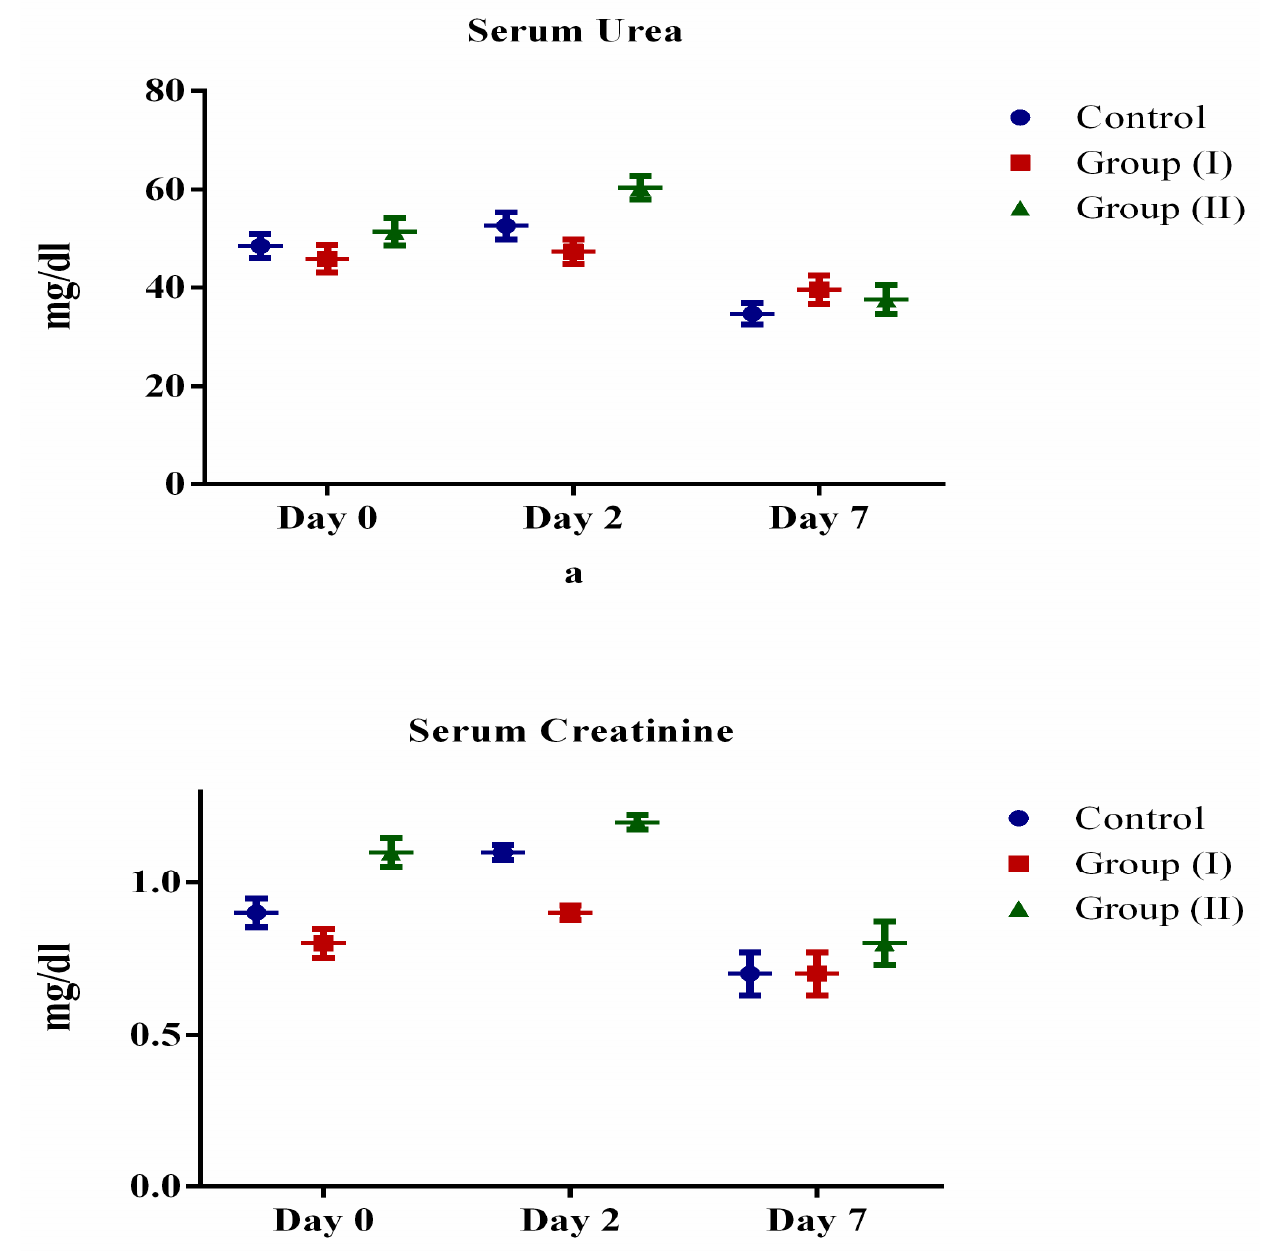
Figure 4. Comparison of kidney function tests between control and treatment groups: ( a ) urea, ( b ) creatinine.